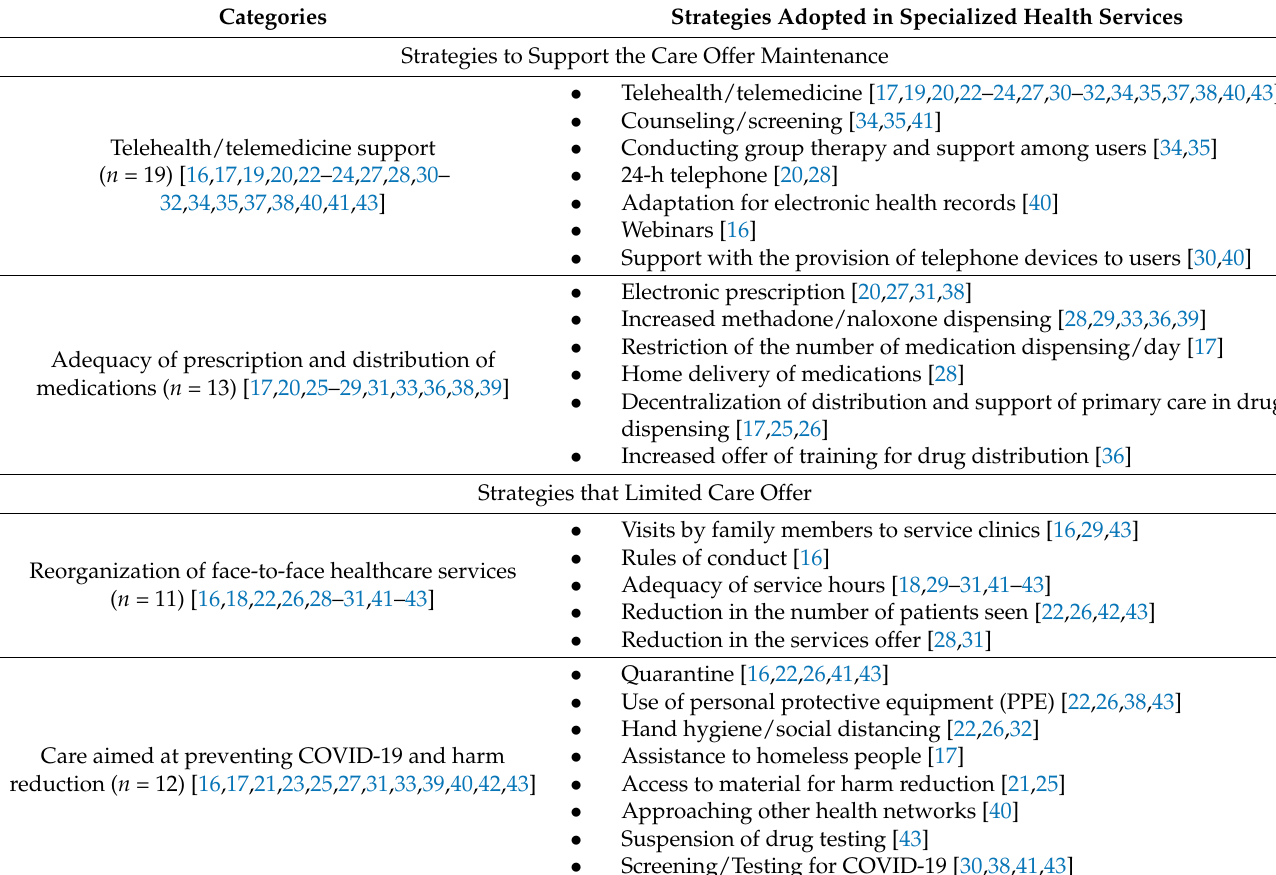
Table 2. Sample distribution according to category, number of studies, and strategies in the services. Brazil, 2021 ( n = 28).